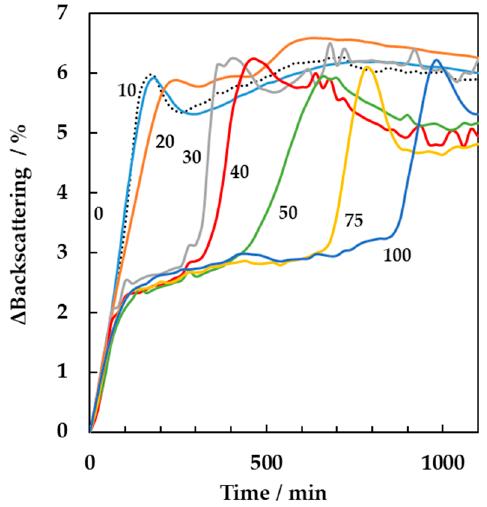
Figure 6. Backscattering spectra over time in absence and presence of ceftiofur antibiotic at concentrations equal to 0, 10, 20, 30, 40, 50, 75 and 100 µg/kg. The fermentation was performed at the incubation temperature of 44 °C with 4.5% ( w/w ) starter concentration. Results are mean values of triplicates.